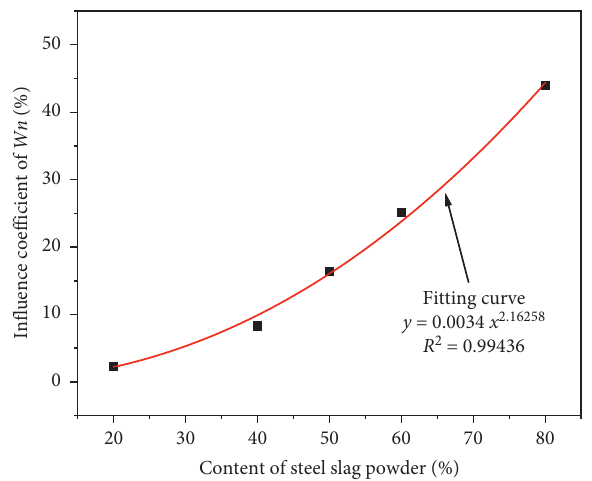
Figure 5: Influence coefficient of steel slag powder content on nonevaporable water content of blended